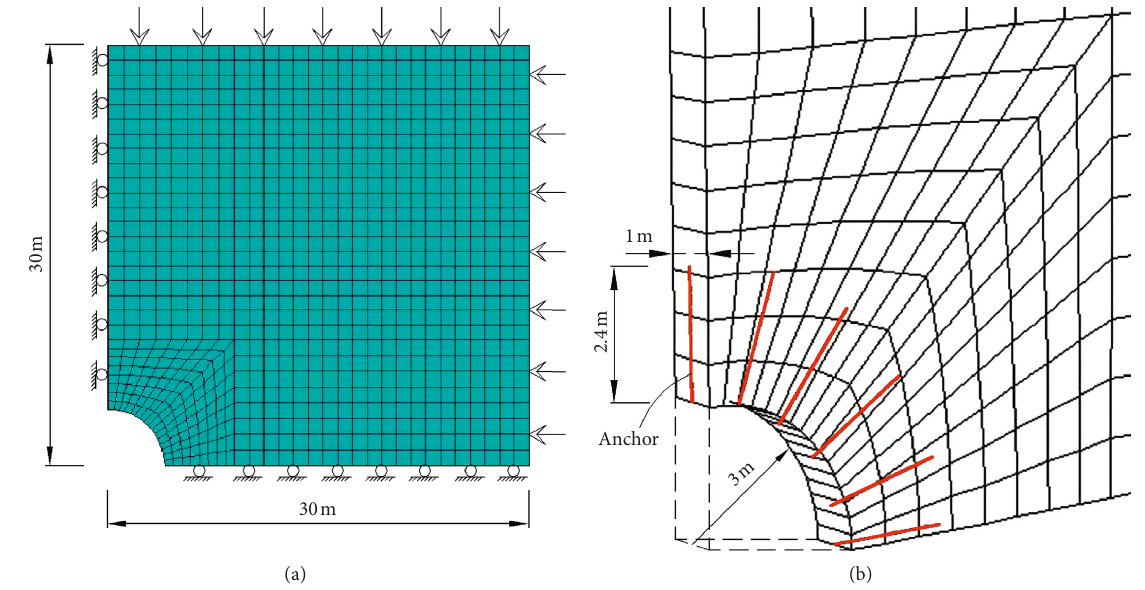
Figure 6: Numerical calculation model: (a) model size and boundary conditions; (b) anchor arrangement.